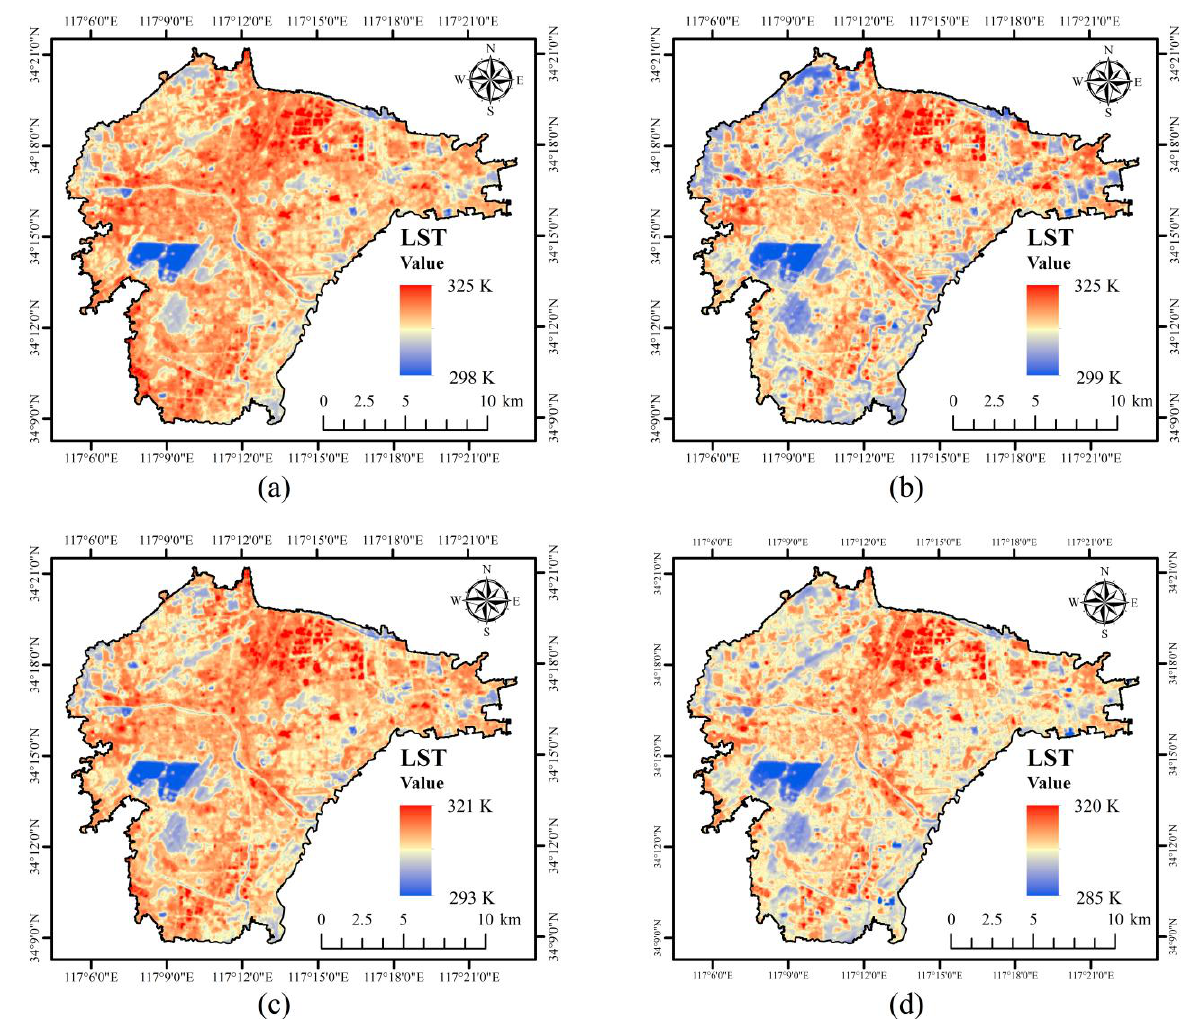
Figure 3. ( a ) Land surface temperature distribution on 21 May 2013; ( b ) 03 September 2013; ( c ) 01 May 2014; ( d ) 22 September 2014.